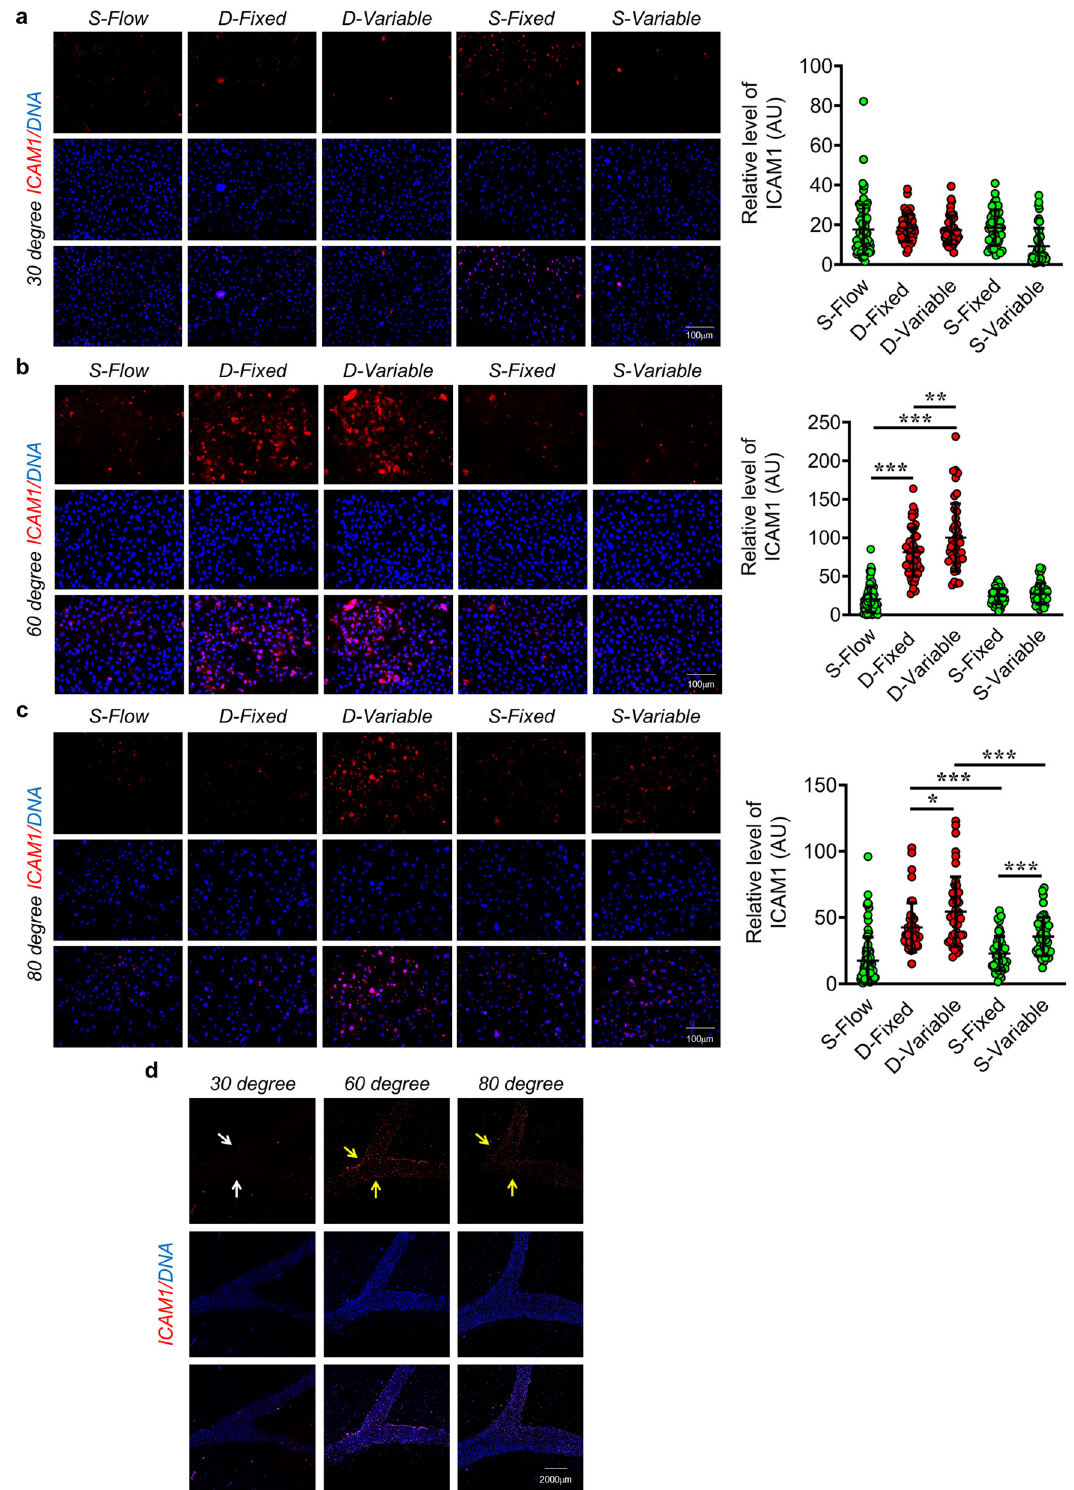
Fig. 4 D-Flow exposure causes elevated expression of pro-in fl ammatory ICAM1 in EC. a – c Immuno fl uorescence staining of EA.hy926 for ICAM1 ( n = 3) after 4 h fl uid fl ow exposure, using human coronary microchannels with 30° ( a ), 60° ( b ) and 80° ( c ) branching points. DAPI staining is shown in blue. ICAM1 fl uorescence signal in individual EA.hy926 cells (dots) from three individual experiments. Fluorescence intensity AU values per individual cells are indicated together with the mean. Total number of cells, n ≥ 45. Values represent the mean ± SD. * p < 0.05, ** p < 0.01 and *** p < 0.001, by one-way ANOVA. Magni fi cation: ×20, Scale: 100 µ m. d Tile scan images microchannels harbouring EC stained for ICAM1. Magni fi cation: ×10, Scale: 2000 µ m.